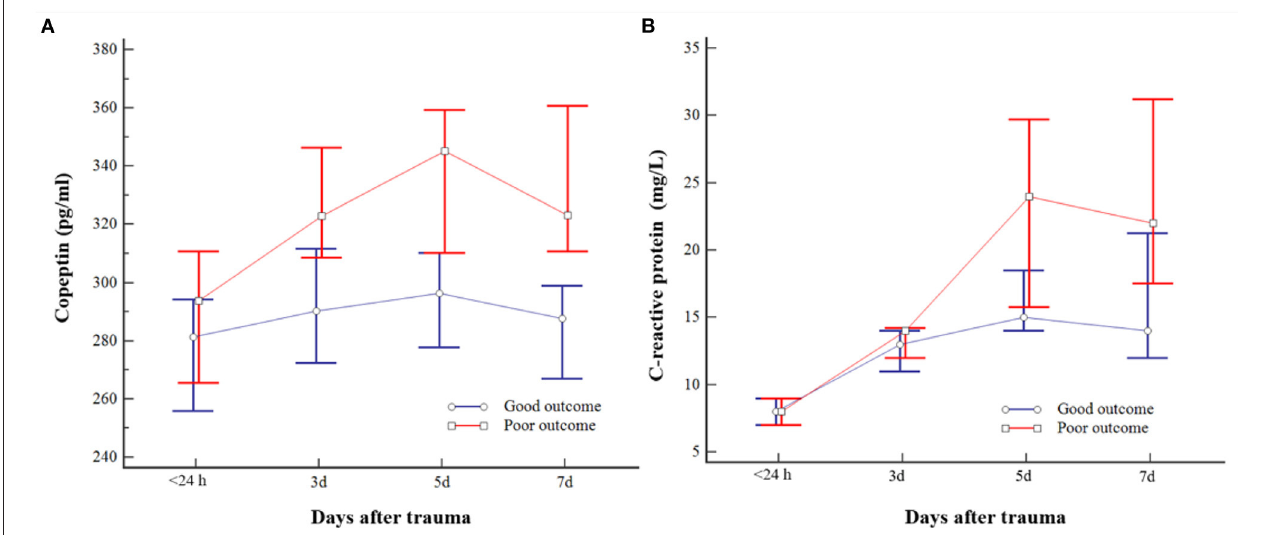
FIGURE 2 | Changes in consecutive plasma copeptin (A) and C-reactive protein (CRP) (B) levels of patients with moderate traumatic brain injury (TBI). The bar indicates the median and 95% CI . Poor outcome following moderate TBI was closely related to copeptin measured on days 3, 5, and 7 and CRP measured on days 5 and 7,